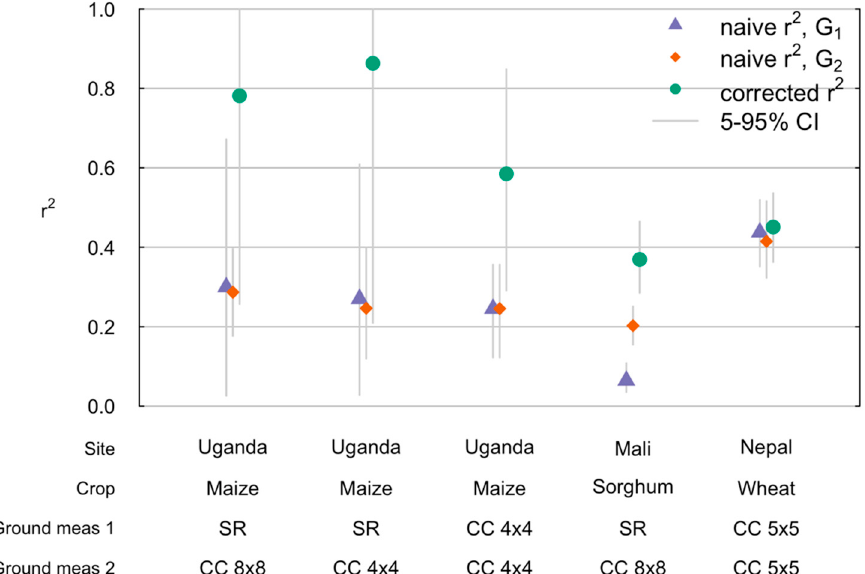
Figure 3. Naïve r 2 understates true performance for satellite crop yield estimation. Comparison of r 2 between satellite-based yields and two different ground-based measures of yields, as well as a corrected r 2 using Equation (14). The confidence intervals (gray bars) were calculated by resampling the fields and recalculating the different r 2 values. The bottom panel indicates the location, crop, and type of ground measures used. Uganda data are from [11], Mali data from [21], and Nepal data from [22].